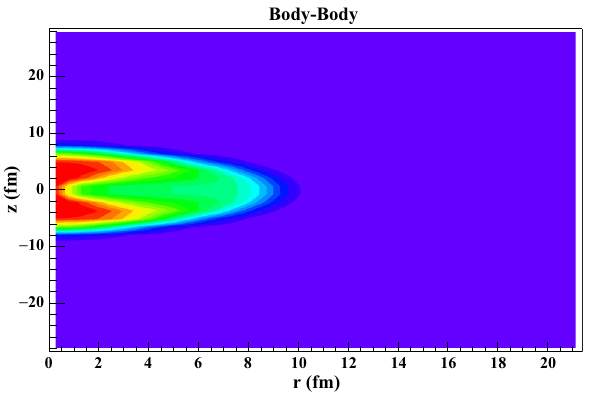
Fig. 3 Nuclear density contour in r − z plane of cylindrical coordinate system for uranium nucleus in body configuration. Representation of colours is same as in the case of Fig. 1